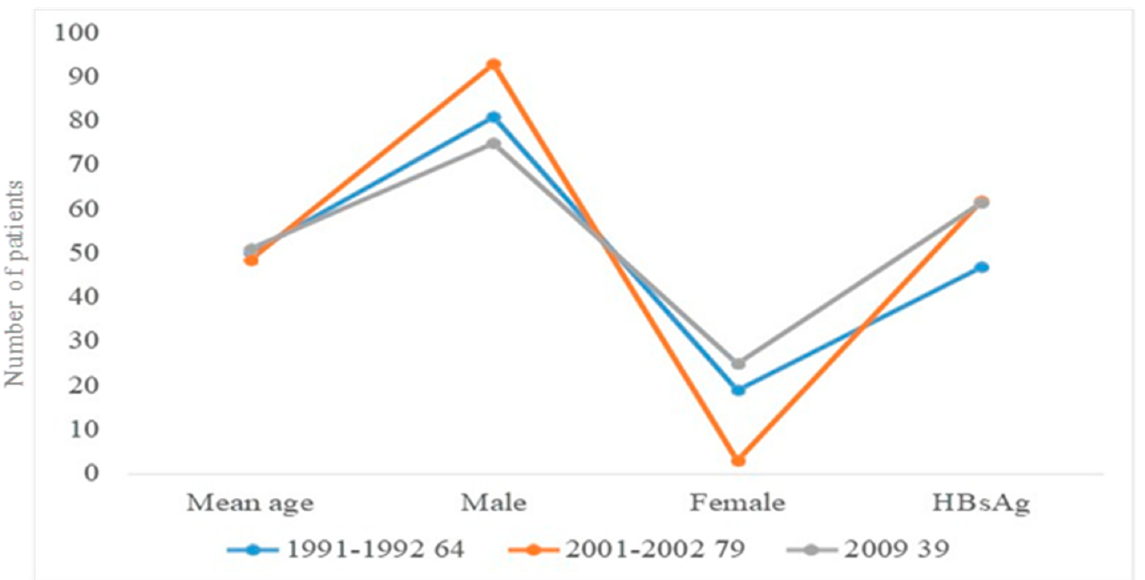
Figure 2. Scenario of hepatocellular carcinoma in Bangladeshi males and females based on age, sex, and HBsAg. Liver carcinoma from 2001 to 2002 was more prevalent in males than in females. A study of 39 male and female patients found the same incidence of HBsAg-related liver carcinoma in males and